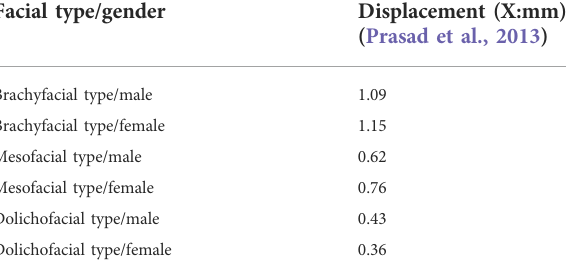
TABLE 5 Mean cohesion displacement of bilateral fi rst molars with wide mouth opening in different facial types and genders. Facial